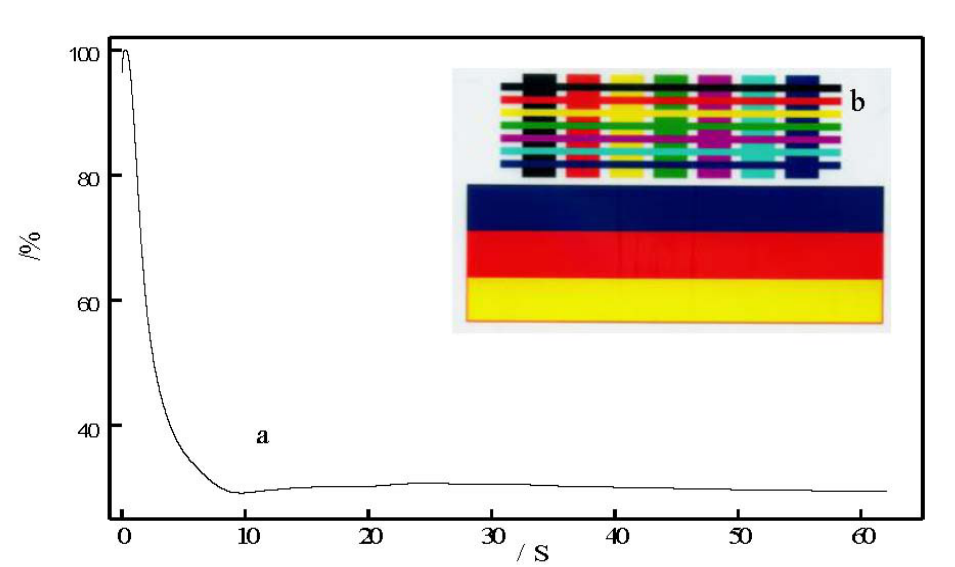
Figure 5. RC-IJP: ( a ) surface infiltration time; and ( b ) the color of the printing